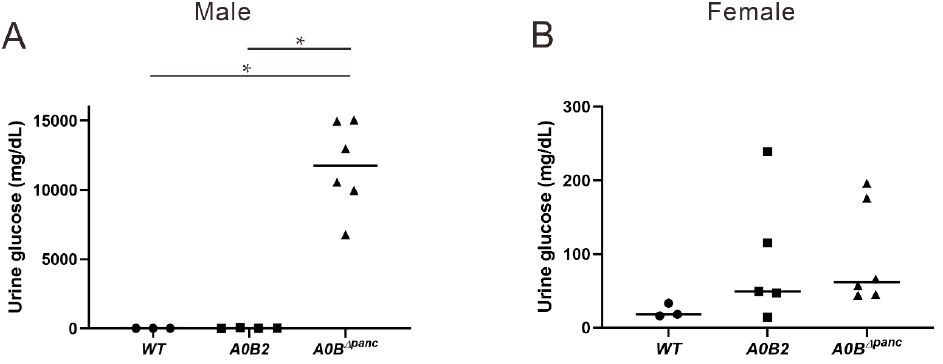
Figure 3. Urine glucose changes among WT , A0B2 and A0B ∆ panc mice. Following 24 h urine collection, glucose level was assayed on 16-week post-TAM male ( A ) and female ( B ) mice of indicated genotypes. The data come from 3–6 mice of each genotype, * p < 0.01.